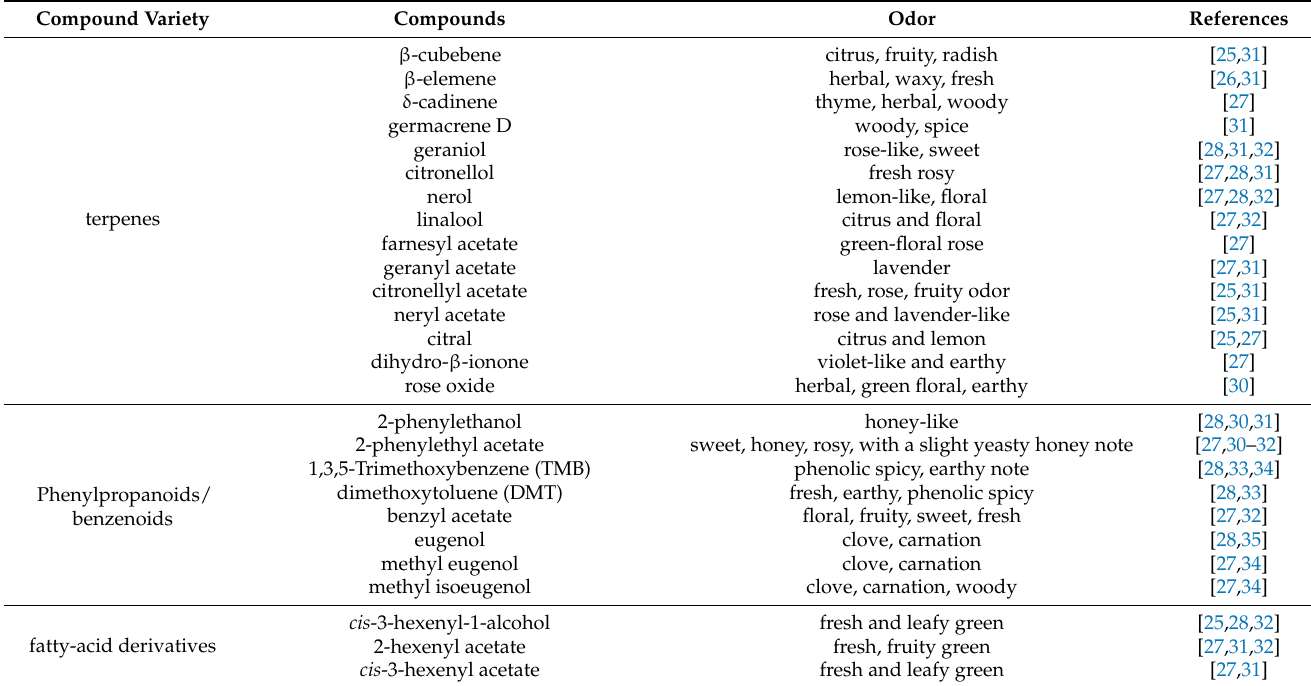
Table 1. Major components of rose floral